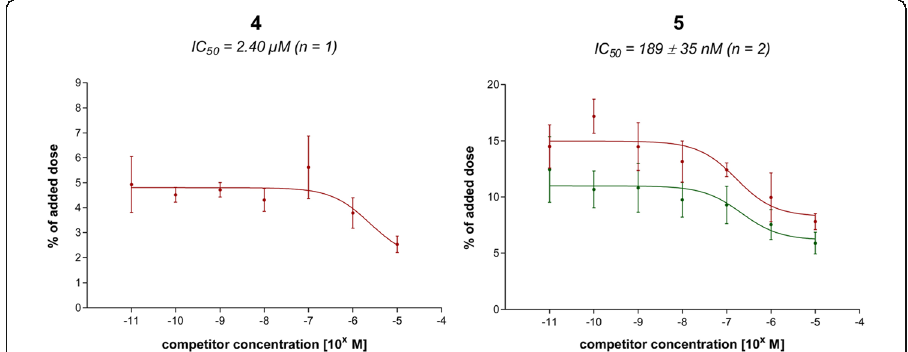
Fig. 3 Sigmoidal dose-response curves for compounds 4 and 5 in 250 μ L HBSS using HEK293-hGLP-1R cells (150,000 cells/well, 4 °C, 2 h) and [Nle 14 , [ 125 I]Tyr(3-I) 40 ]exendin-4 (0.41 nM) as